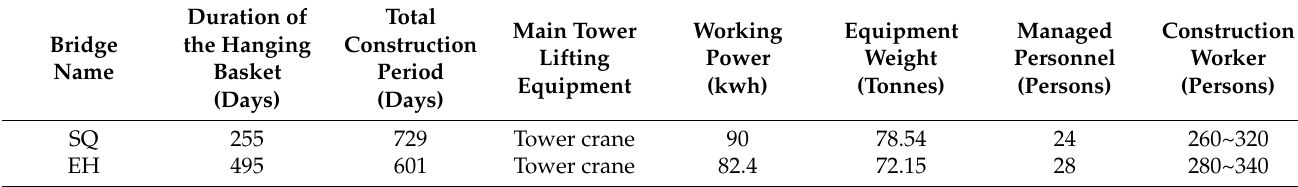
Table 2. Data summary table for construction.